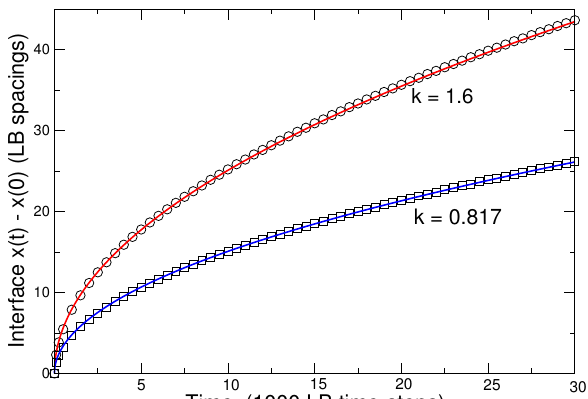
Figure 2. Results of solution of Stefan problem from LB (symbols) and analytic results (lines) with diffusion constant D = 1/6 and k shown next to each set of